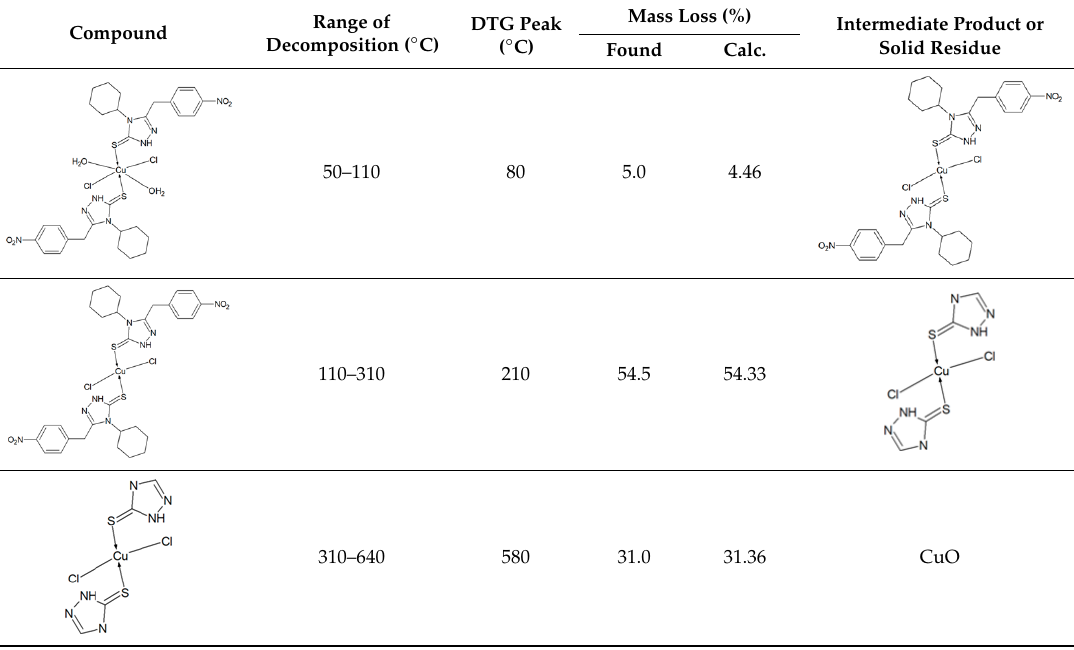
Table 1. TG-DTG analysis data for decomposition process of copper(II) complex.